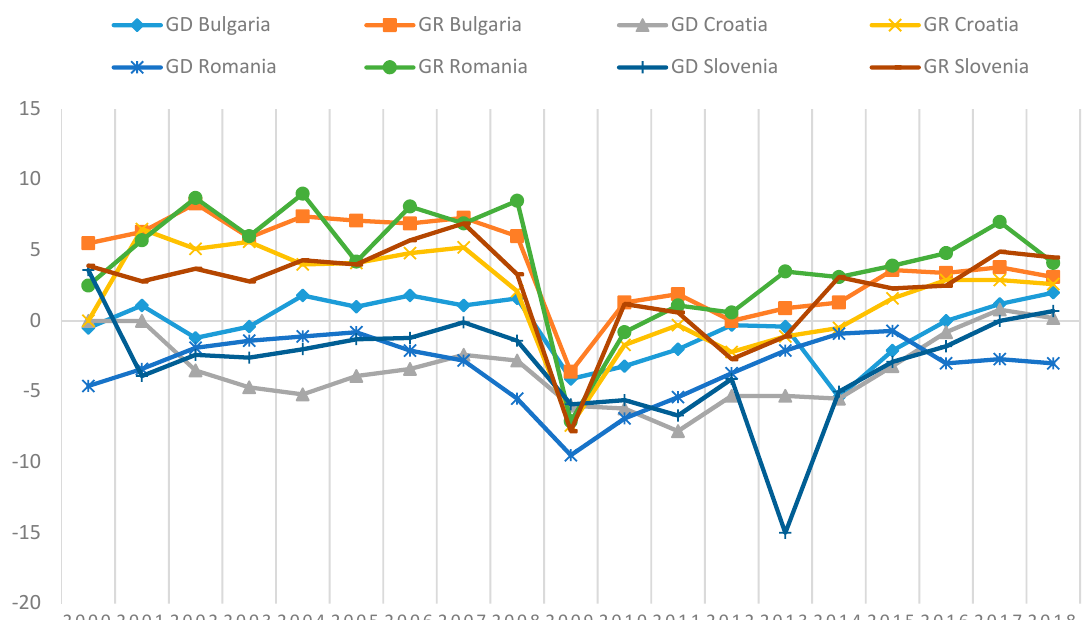
Figure 7. The Balkan countries’ GD percentage of GDP versus growth rate percentage change from previous year, 2000–2018; Source: Eurostat.